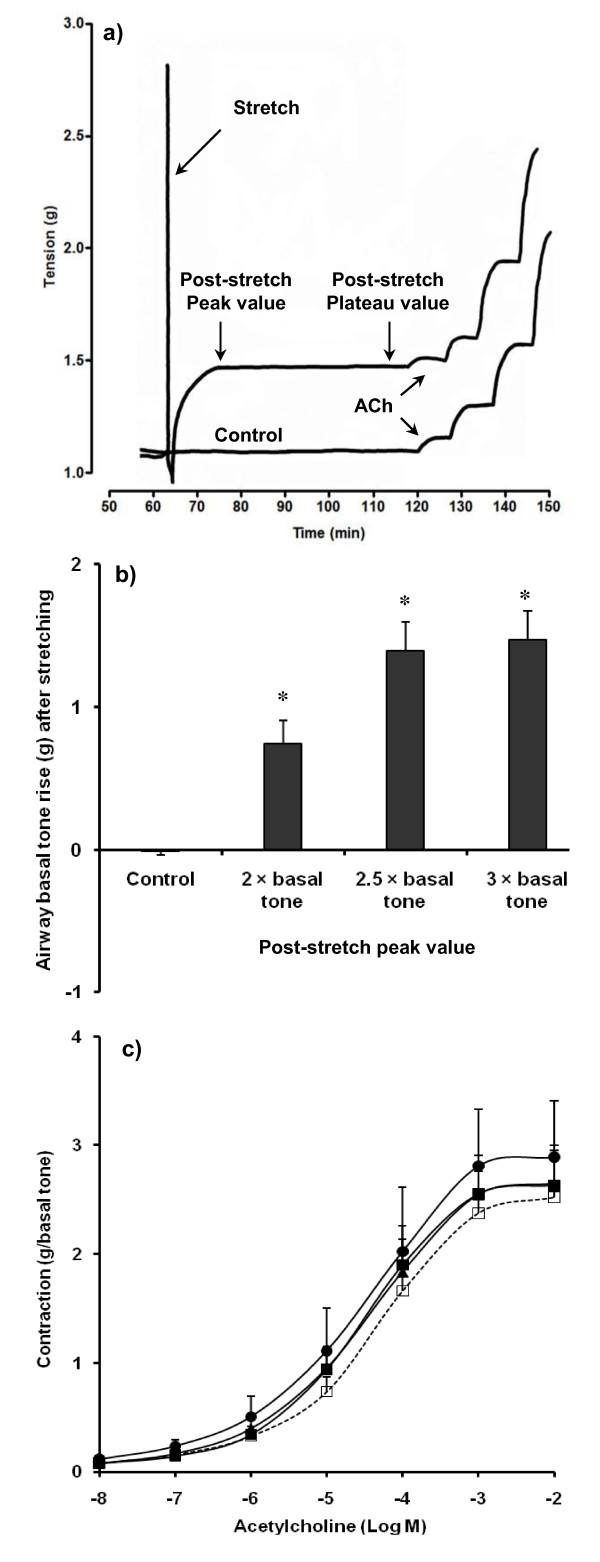
Effect of mechanical stress on airway tone and responsiveness. (a) Basal tone and responsiveness to acetylcholine (ACh) in single control and stretched human bronchial rings. After tissue equilibration in an organ bath for 60 minutes, acute mechanical stretch (5 minutes, 2.5 × basal tone) provokes a quick rise of basal tone (immediate contraction corresponding to post-stretch peak) followed by a prolonged plateau (sustained contraction). (b) Post-stretch peak is strain-dependent with a maximal response for a tension corresponding to 2.5-fold resting basal tone in 11 human bronchial rings. (c) Responsiveness to ACh is not significantly altered by stretching in the same 11 paired bronchial rings. Filled squares, stretch 2 × basal tone; filled triangles, stretch 2.5 × basal tone; filled circles, stretch 3 × basal tone; open squares, paired controls. Values are means ± standard error of the mean. *P < 0.001 vs. paired control.